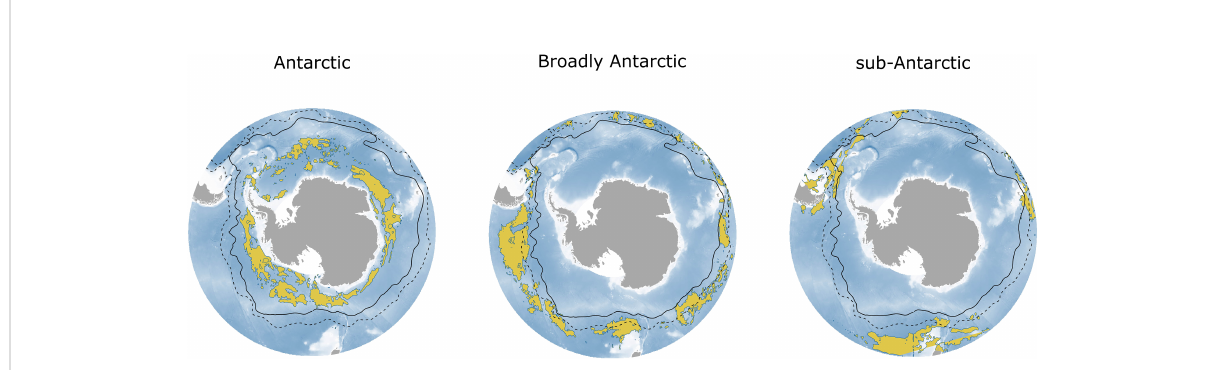
FIGURE 6 The total combined night-time abundance by the broad groupings: ‘ Antarctic ’ , ‘ Broadly Antarctic ’ and ‘ sub-Antarctic ’ . Abundance is shown in yellow as the 90th percentile (top decile) of the predicted abundance across the Southern Ocean. The ‘ Antarctic ’ grouping includes Bathylagus spp. and E. antarctica ; ‘ Broadly Antarctic ’ includes E. carlsbergi, K. anderssoni, P. tenisoni, G. nicholsi and G. braueri ; and ‘ sub-Antarctic ’ includes P. bolini only. The black solid line shows the position of the polar front (PF), and the black dashed line shows the position of the sub-Antarctic front